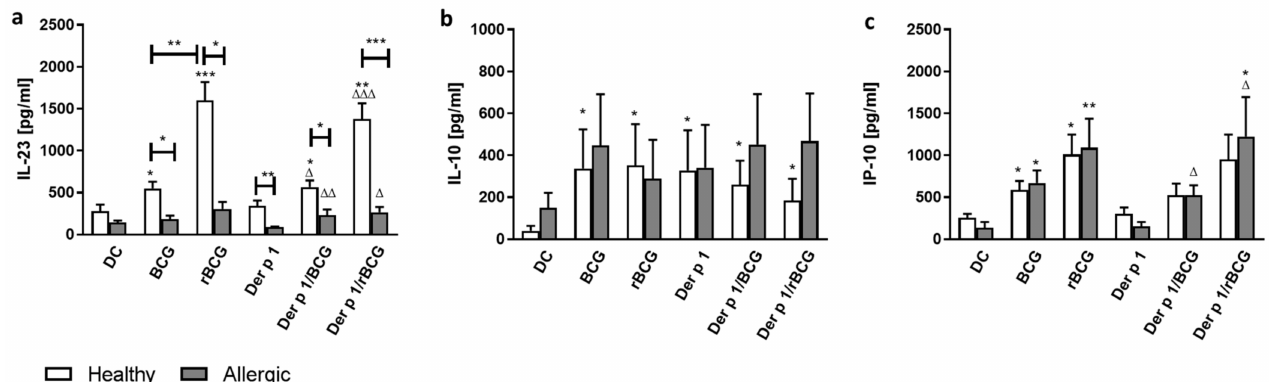
Figure 2. IL-23 ( a ), IL-10 ( b ) and IP-10 ( c ) production by stimulated MD-DCs from allergic patients and healthy donors. Human MD-DCs were stimulated with BCG (1:1), rBCG-hIL-18 (rBCG) (1:1), Der p 1 (1 µ g/mL), Der p 1/BCG or Der p 1/rBCG for 24 h or were left unstimulated (DC). The cytokine (IL-23, IL-10) and chemokine (IP-10) levels in culture supernatants were measured in duplicate by ELISA. Data shown represent the medians ± SEM for 22 allergic patients and 40 healthy donors. Statistical analyses were performed by using the Mann–Whitney U test for unpaired data. * p < 0.05; ** p < 0.01; *** p < 0.001 versus control (unstimulated DC), unless indicated by the horizontal bars, ∆ p < 0.05; ∆∆ p < 0.01; ∆∆∆ p < 0.001 versus Der p